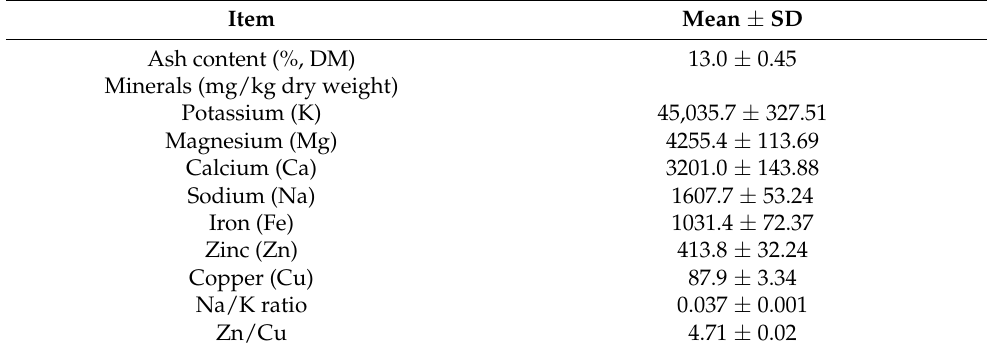
Table 2. Ash content and mineral composition of A. iva leaves (n = 3 samples, 3 replicates per sample).